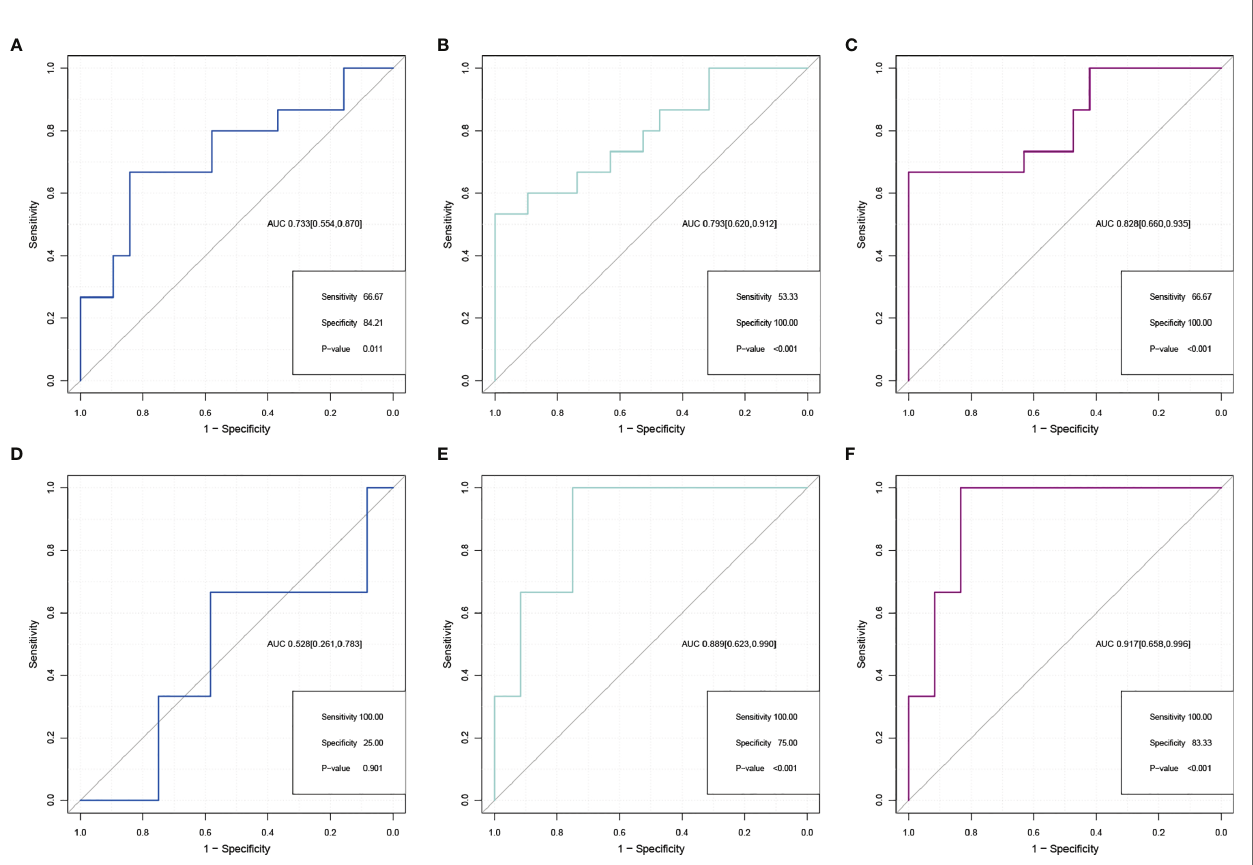
FIGURE 7 | Comparison of ROC analysis between gene pair and separate gene in predicting IDD in the expanded dataset (A – C) and external validation dataset (D – F) . ROCs for CCNB1 (A, D) , PKD1 (B, E) , and CCNB1 – PKD1 pairs (C, F)